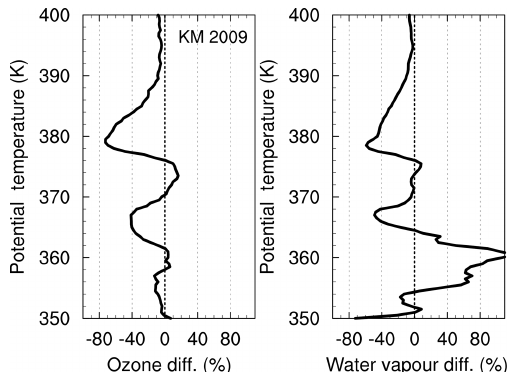
Figure A2. Ozone and water vapour relative difference on 8 Au- gust 2009 for the climatological mean value for August 2009.